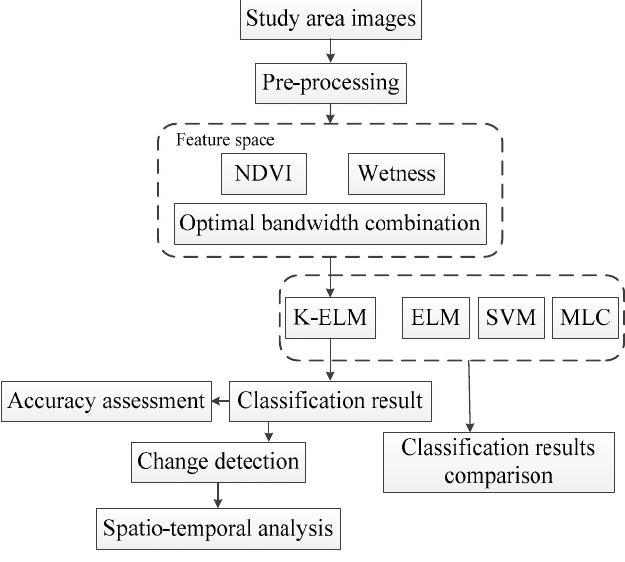
Figure 2. The main process in this study.